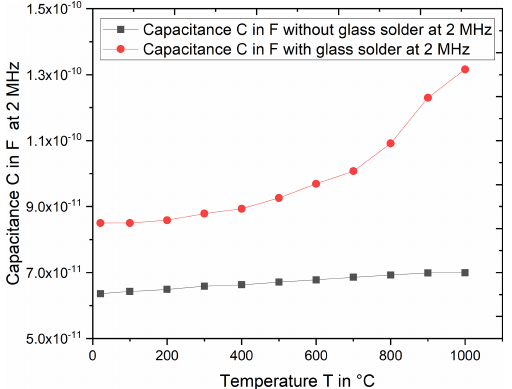
Figure 20. Capacitance of the test structure (Fig. 3), with and with- out glass solder, up to 1000 ◦ C.